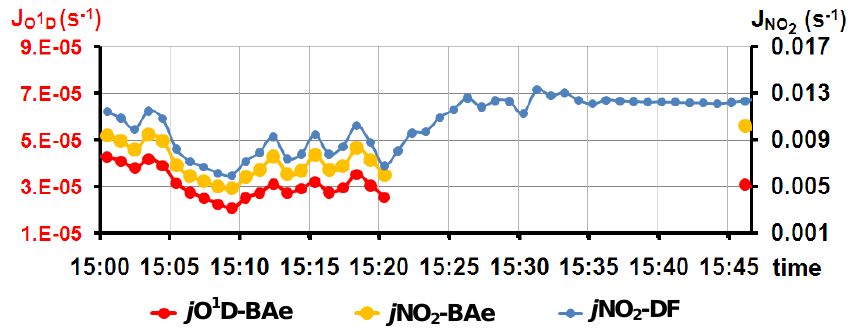
Fig. 7. Temporal variability of the photolysis rates measured during the AMMA intercomparison exercise. DF stands for D-Falcon and BAe for BAe-146.